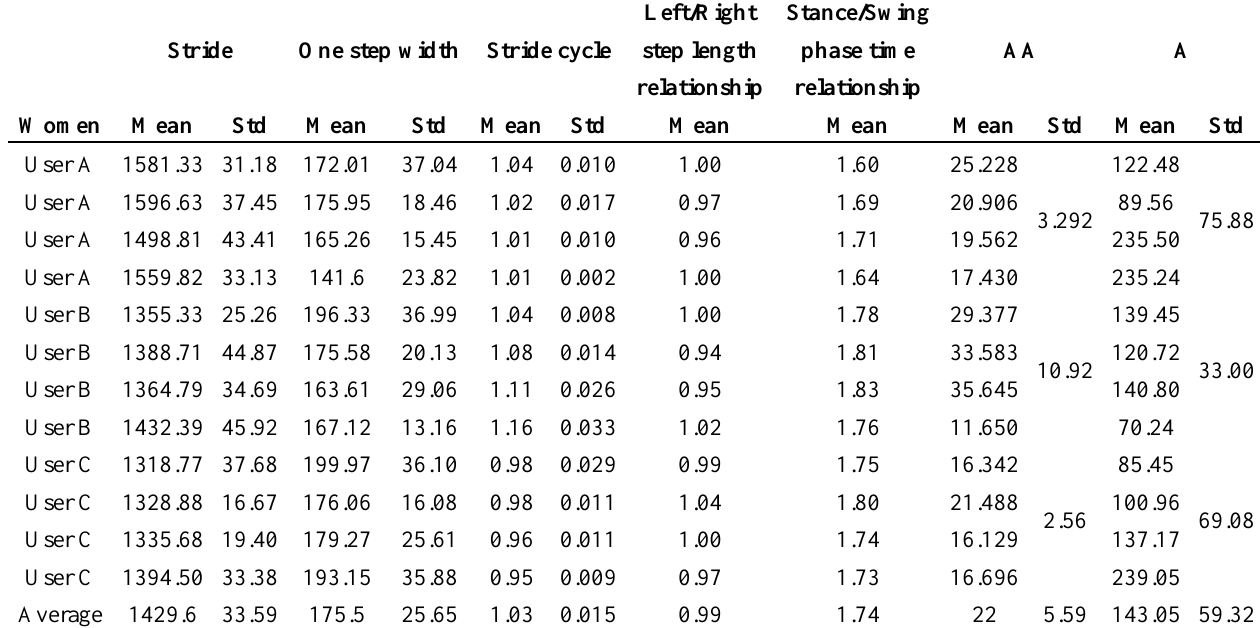
Table 1. Gait parameters of three women.